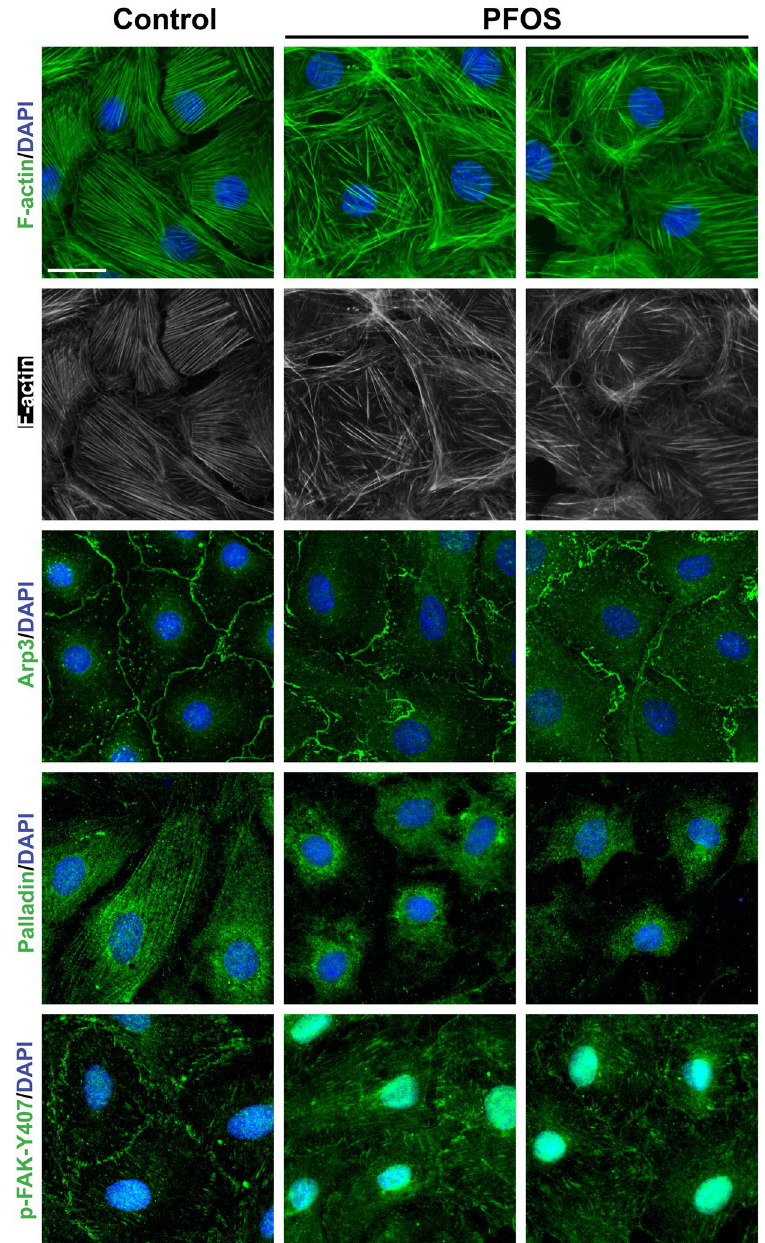
Figure 2. Immunofluorescence analysis to assess the effects of PFOS on the organization of actin microfilaments in Sertoli cells via changes on the distribution of actin regulatory proteins. Sertoli cells cultured for 3 days were treated with 20 μ M PFOS for 24 hr. Cells were then harvested and used for IF, and results from two different experiments were shown in middle and right columns vs . the control cells in the left column. PFOS caused truncation and defragmentation of F-actin network (green and gray). These changes in the organization of actin microfilaments were likely the result of changes in the spatial localization of several actin regulatory proteins. Arp3, a branched actin polymerization protein that effectively converted actin microfilaments into a branched/unbundled configuration no longer localized at the cell-cell interface to support F-actin dynamics at the cell cortical zone. Instead, Arp3 was internalized and found in the Sertoli cell cytosol, thereby impeding actin microfilaments to organize as long actin bundles stretched across the cell cytosol. Palladin, an actin cross-linking and bundling protein, no longer stretched across the Sertoli cell cytosol to maintain actin microfilaments across the Sertoli cells as found in control cells. Instead, palladin was retracted from the cell peripheries but concentrated to cell nuclei after PFOS treatment. p-FAK-Y407, a signaling protein shown to be involved in maintaining BTB integrity by maintaining F-actin network in Sertoli cells as actin filament bundles also no longer localized to the Sertoli cell-cell interface to maintain the TJ-barrier function. Instead, it was internalized into the cell cytosol, thereby destabilizing the TJ-barrier function. Sertoli cell nuclei were visualized by DAPI. Scale bar, 30 μ